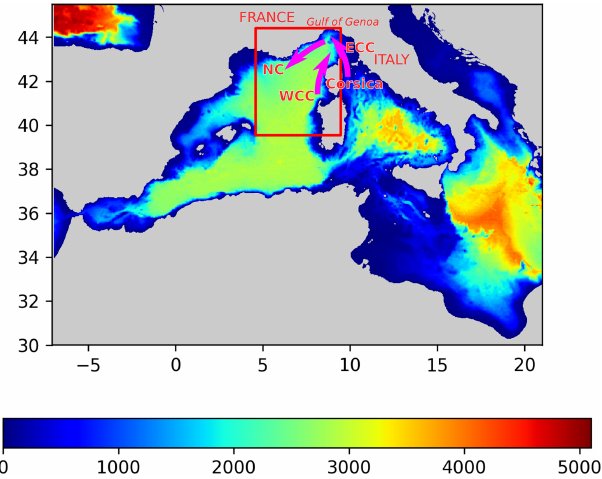
Figure 1. The red rectangle delimits the studied region, and the color represents the bathymetry in meters. The arrows represent the main currents: the Western Corsican Current (WCC), the Eastern Corsican Current (ECC) and the Northern Current